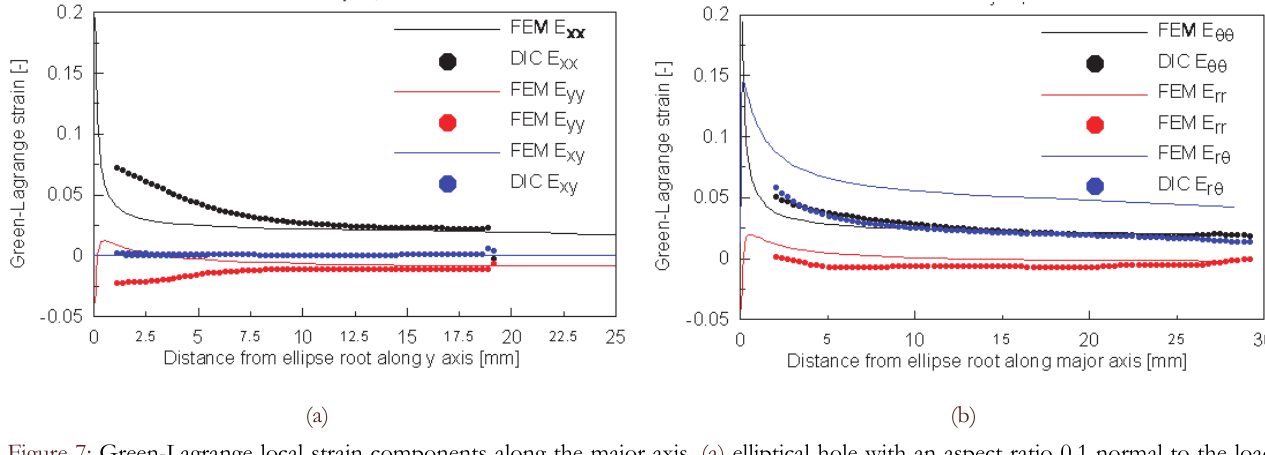
Figure 7: Green-Lagrange local strain components along the major axis. (a) elliptical hole with an aspect ratio 0.1 normal to the load axis (axial normal strain = 2.01%); (b) elliptical hole with an aspect ratio 0.1, 60° inclined with respect to the load axis (axial normal strain =